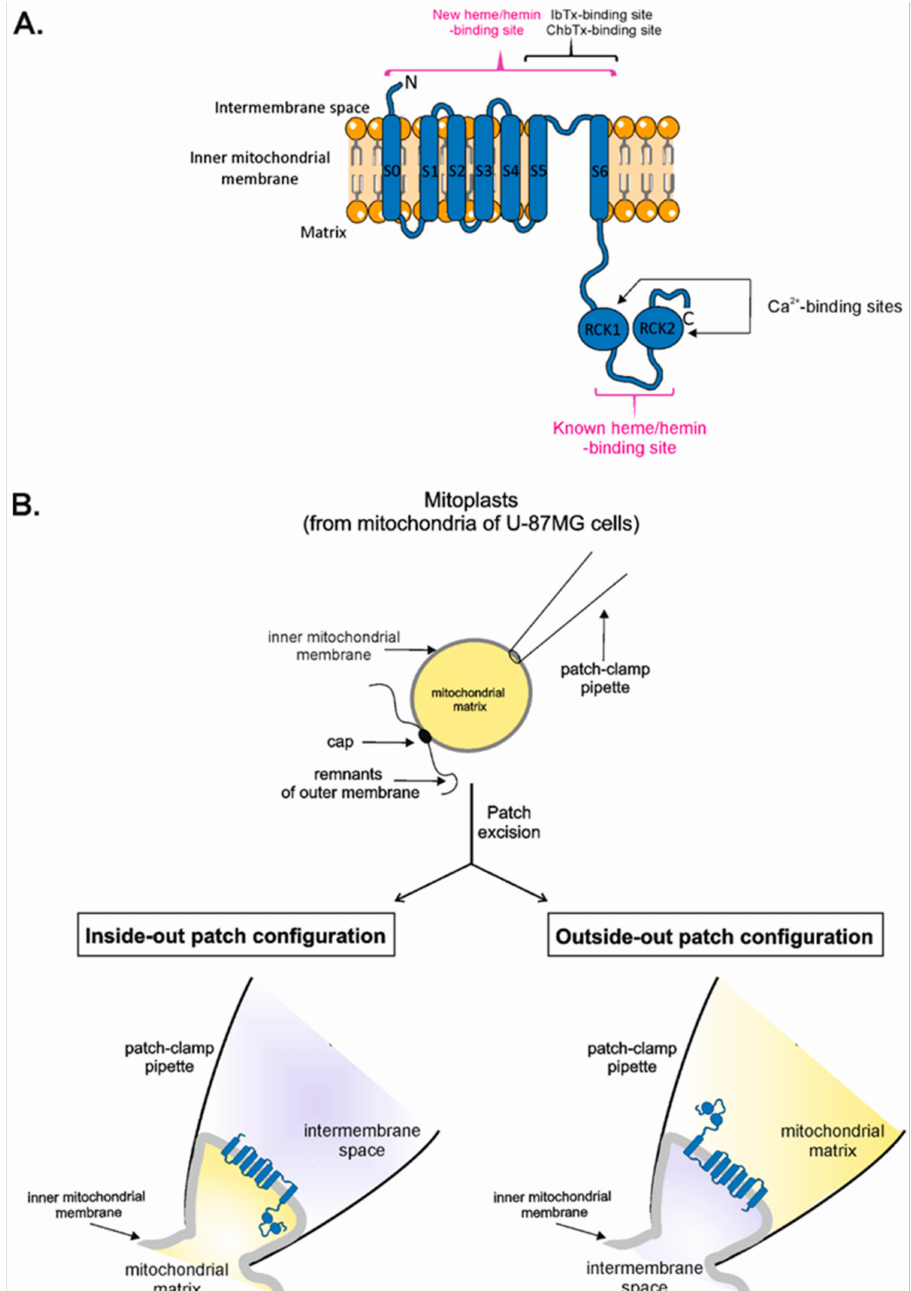
Figure 1. Topology of the mitoBK Ca channel α subunit and scheme of patch-clamp experiments in different configurations. ( A ) Schematic topology of mitoBK Ca α subunit with marked binding sites for selected modulators of the mitoBK Ca channel activity. Binding sites for Ca 2+ in the mitoBK Ca channel are located on the mitochondrial matrix side, while iberiotoxin- and charybdotoxin-binding sites are present on the external, intermembrane space side of the channel. The known heme- binding site (CXXCH) is located in the linker between RCK domains in the C-terminus, while a new hypothetical external heme-binding site is located on the intermembrane space side of the mitoBK Ca channel. ( B ) Schematic representation of patching of the mitoplast and patch-clamp experiments in the inside-out and outside-out modes. For details of patch-clamp measurements see the “ Materials and Methods ”